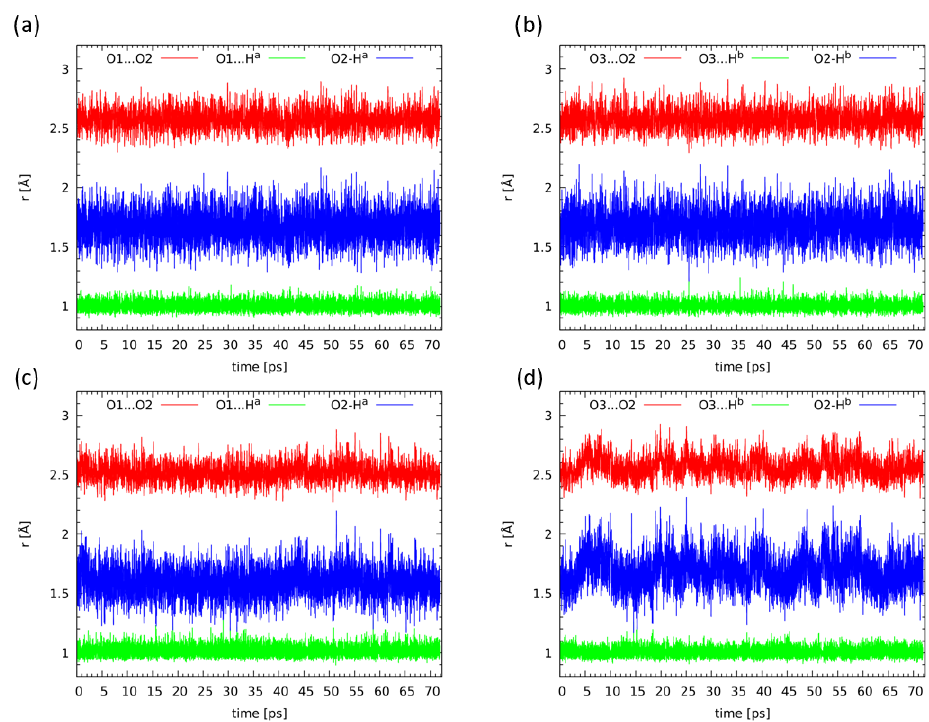
Figure 9. Time-evolution of interatomic distances of atoms involved in the intramolecular hydrogen bonds formation of the compound 2 , ( a , b ) results obtained from CPMD in vacuo while ( c , d ) in the crystalline